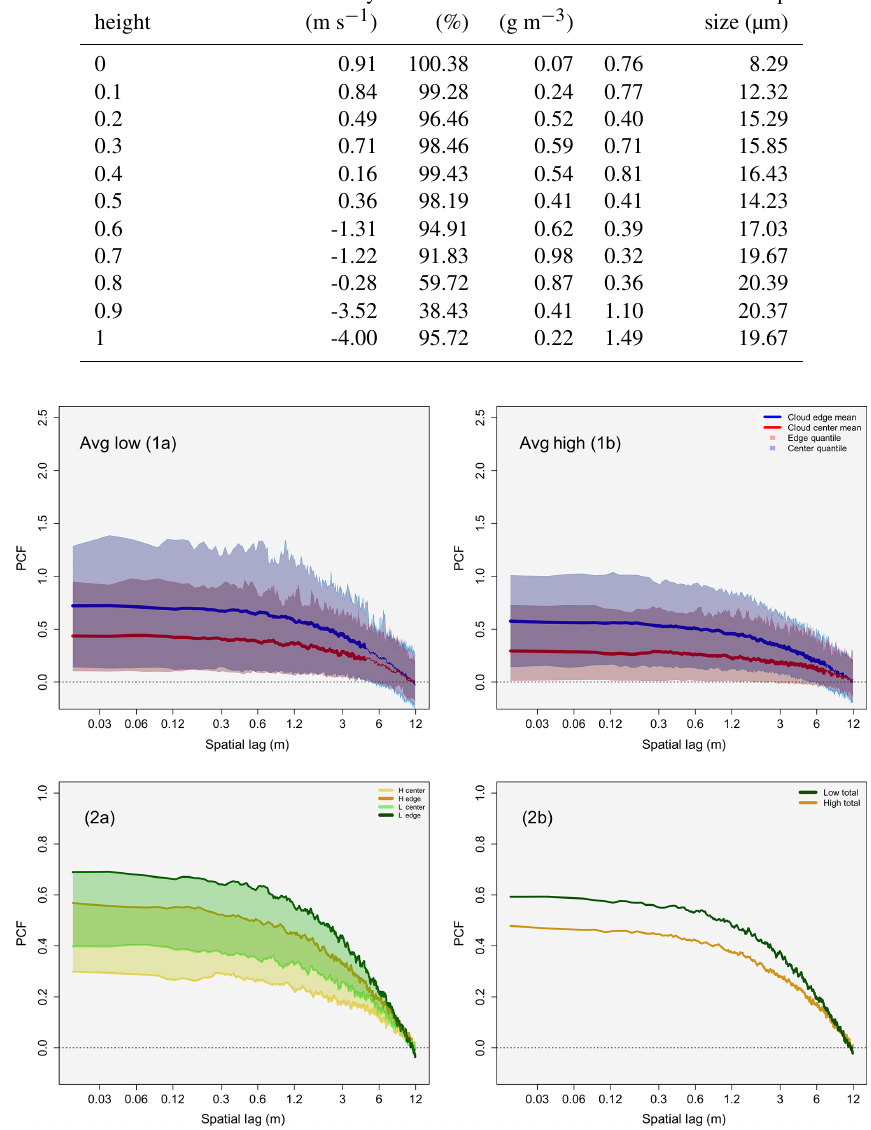
Figure 9. Panels (1a) and (1b) : as in Fig. 5, except for average low-pollution PCF values (L1, L2) in panel (1a) and average high-pollution PCF values (H1, H2) in panel (1b) . Panels (2a) and (2b) : low-pollution data in green and high-pollution data in gold. Panel (2a) shows envelopes that span the mean center PCF value (lower limit of the envelopes) to the mean edge PCF value (upper limit of the envelopes). Panel (2b) gives the overall mean PCF for low- and high-pollution